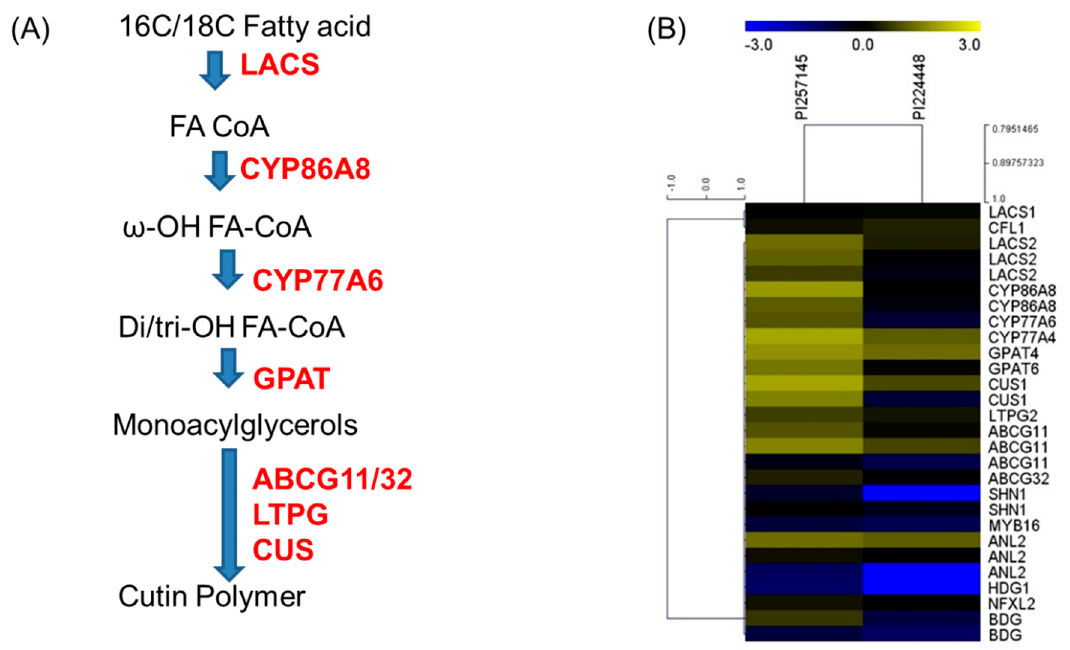
Figure 7. ( A ) Putative cutin biosynthetic pathway predicted in Capsicum chinense based on RNA-Seq data. ( B ) Expression of genes involved in cutin biosynthesis, transport, and regulation between the two genotypes PI 224448 and PI 257145 based on FPKM-normalized Log10-transformed counts. The color yellow represents high expression and blue represents low expression.